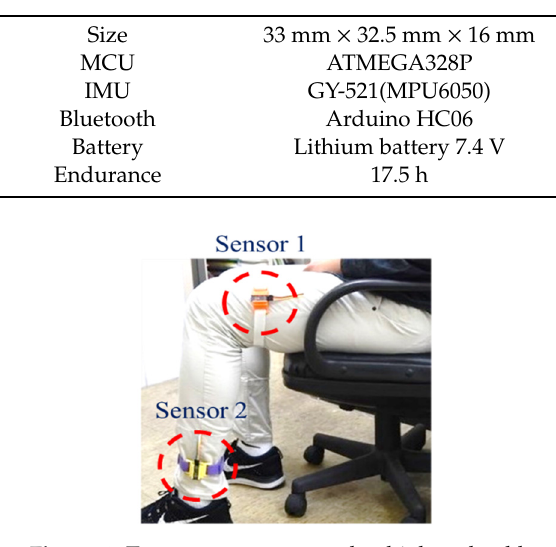
Figure 3. Developed sensor device. Table 1. Specifications of the developed sensor device.